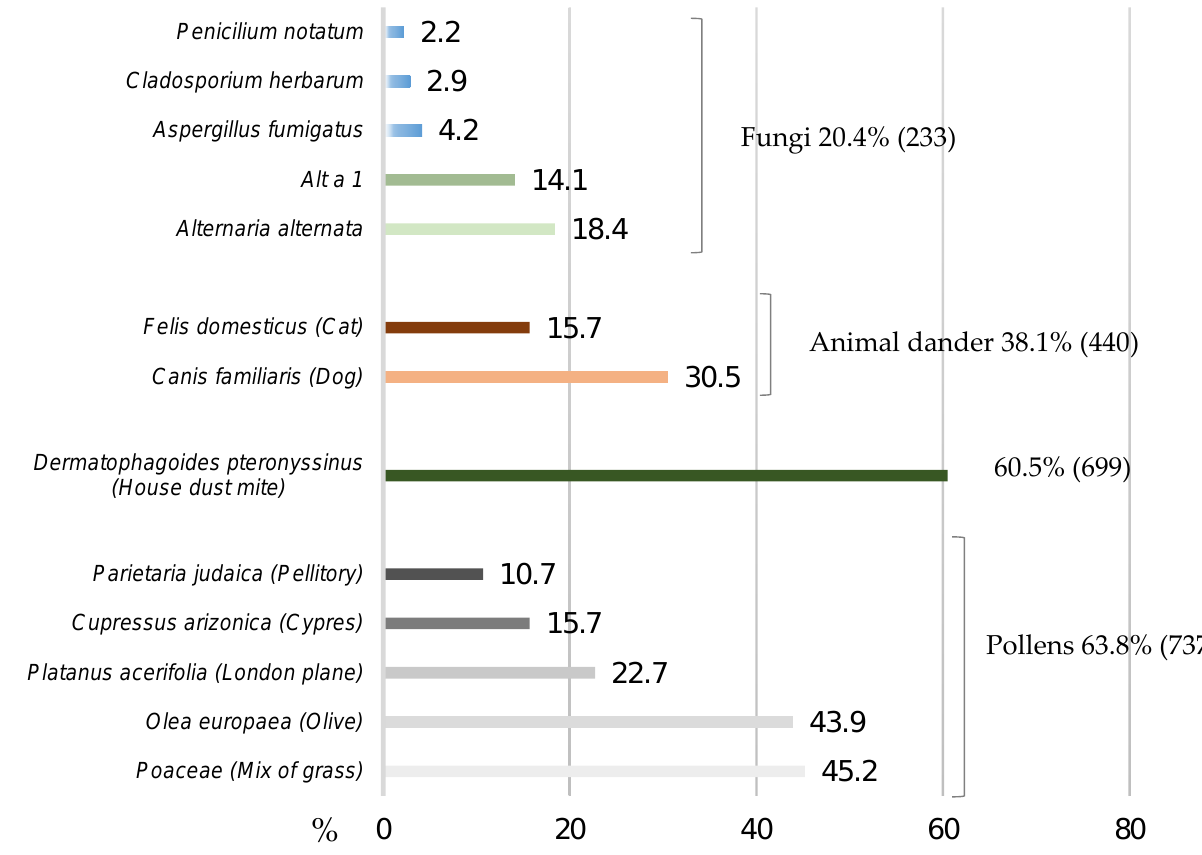
Figure 2. SPT results by allergen source (%). Table 2. Patients sensitized to fungi and Alternaria alternata and Alt a 1 by center.